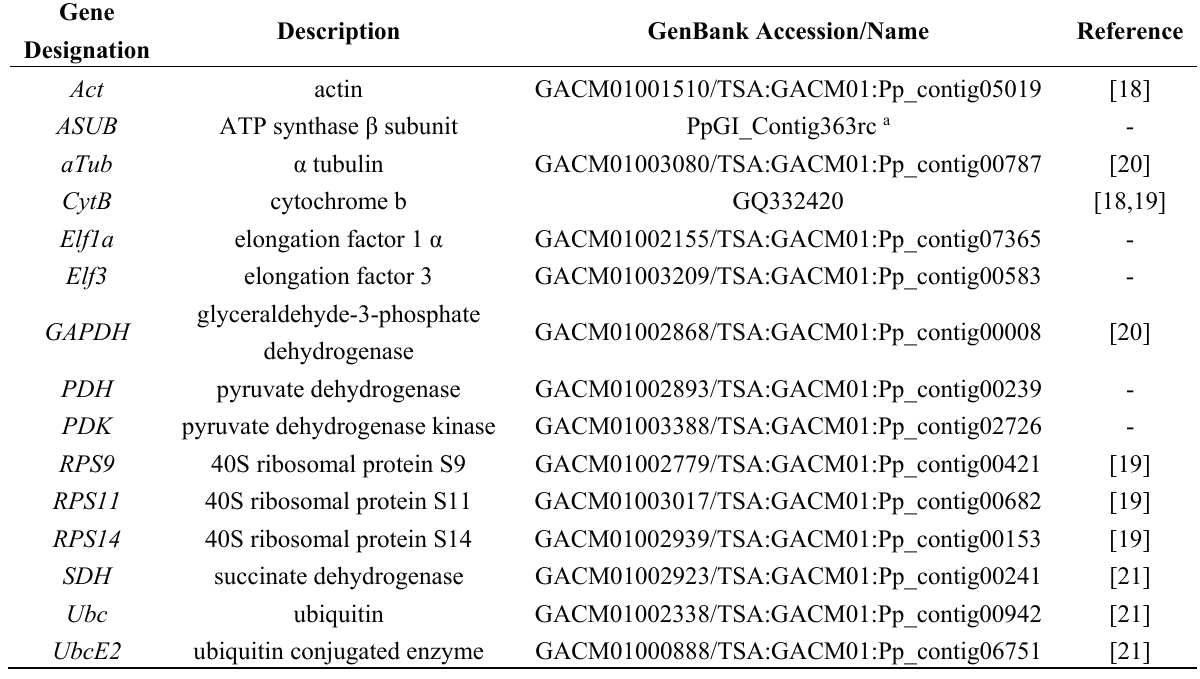
Table 1. Candidate reference genes for P. pachyrhizi